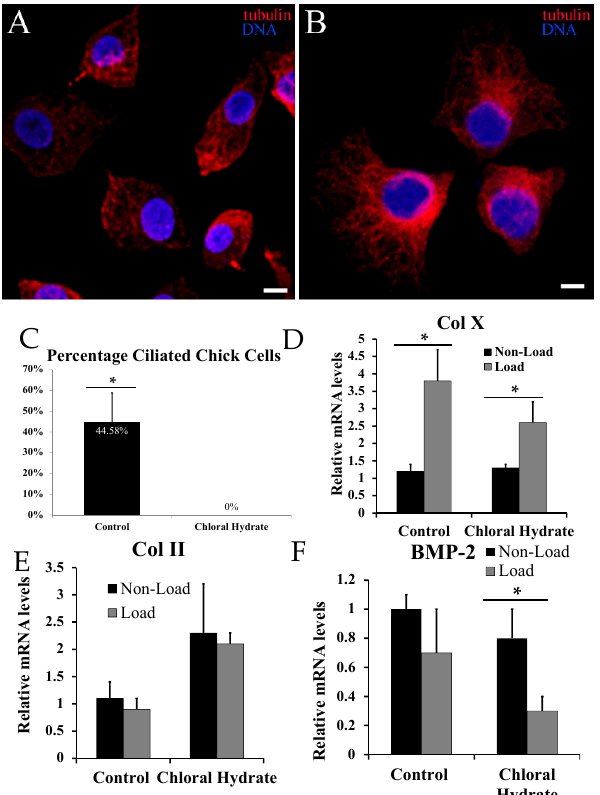
Figure 3. Confocal microscope image showing a field of chick primary chondrocytes treated with control ( A ) or chloral hydrate-containing culture medium ( B ). Primary cilia are red structures extending from the cell surface of the control-group cells ( A ) but absent in the chloral hydrate treated cells ( B ); acetylated α -tubulin is stained red; DNA is stained blue with DAPI (scale bars: 10 µm). Immunocytochemistry analysis indicated that treatment with chloral hydrate decreased the number of ciliated cells by from 44.6% in controls to 0% ( C ). A statistically significant difference in relative Type X collagen (Col X) mRNA was present between loaded and non-loaded cells treated with control ( D ). This statistically significant difference was still present but again smaller in those treated with chloral hydrate. There was no statistically significant difference in relative Type II collagen (Col II) mRNA levels ( E ). There was a statistically significant decrease in relative bone morphogenetic protein 2 (BMP-2) mRNA levels in loaded versus non-loaded chloral hydrate-treated cells which was not present in controls ( F ). Values normalized to 18S rRNA. Statistically significant values are represented by *.